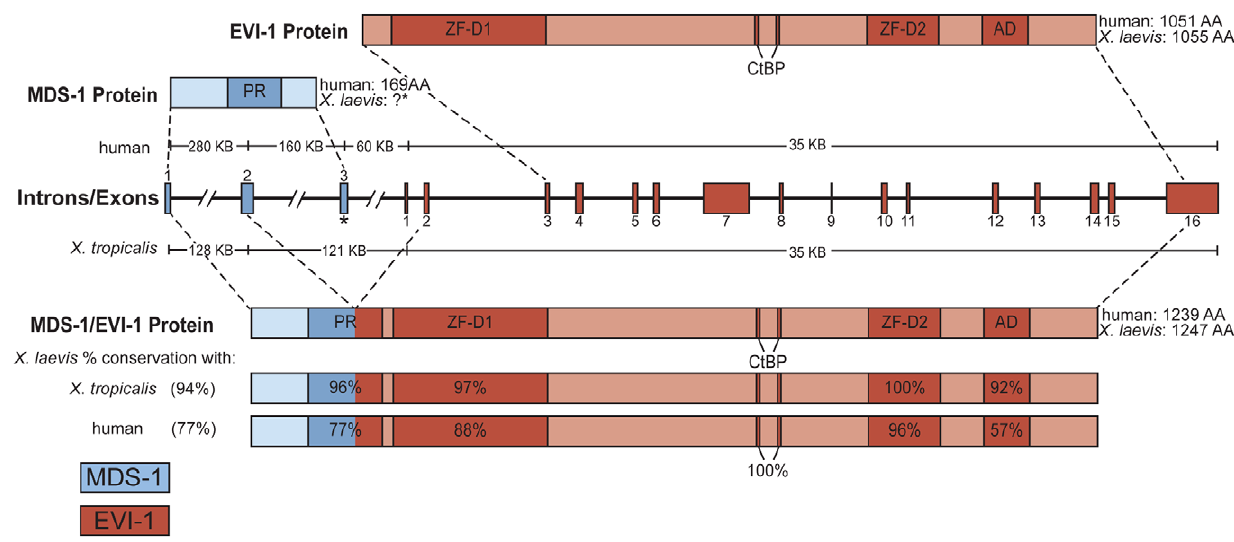
Figure 1. Structure and conservation of EVI and MDS in humans, X.laevis , and X.tropicalis . There are 16 exons for human and X. tropicalis EVI and 3 exon for human MDS. In X. laevis , as in humans, exon 2 of MDS can be spliced to exon 2 of EVI to form a larger, fusion transcript MDS/EVI. The % identity of the PR (PRDI-BF1 and RIZ homology domain containing) domain, zinc finger domains (ZF-D) 1 and 2, C-terminal binding protein (CtBP) domain, and acidic domain (AD) are indicated. For an alignment of the EVI amino acid sequence, see [21]. Note that despite an exhaustive search by using RACE and in silico methods, no MDS exon 3 could be found in X. laevis or X. tropicalis , although a 3 9 end of MDS exon 2 that is not present in MDS/EVI fusion transcript was cloned by using RACE (not shown). Thus, the existence of the MDS transcript and encoding protein remains unknown as indicated with a question mark in the figure.